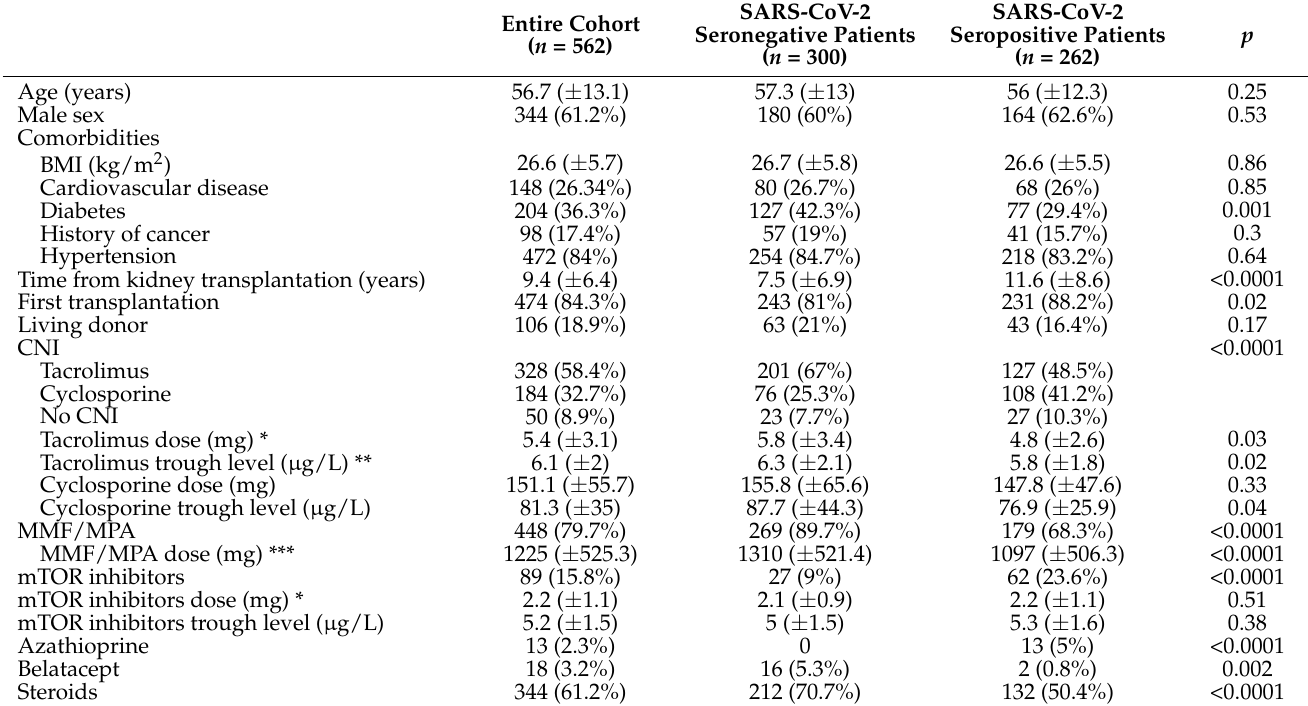
Table 1. Patient characteristics according to the absence or presence of seroconversion after two vaccine